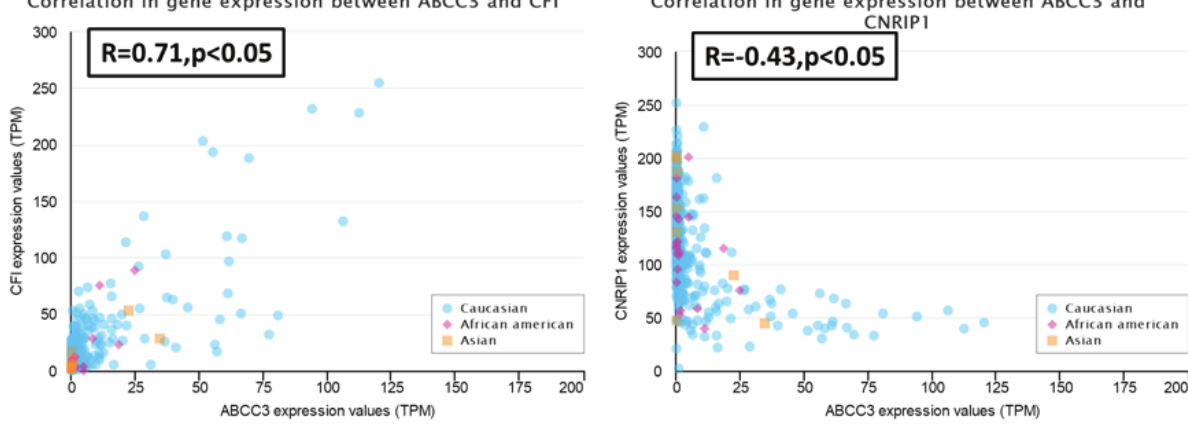
Figure 4: Positive and negative expressioncorrelation analysis of ABCC3 in glioma(A: positive correlation of CFI gene with ABCC3; B:negative correlation of CNRIP1 gene with